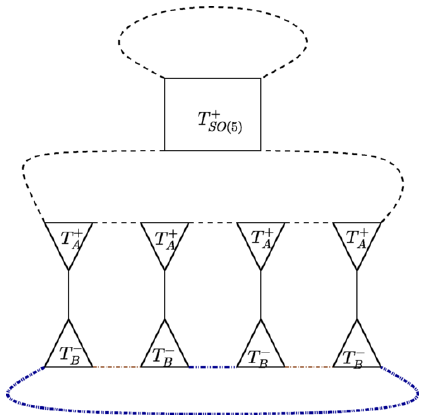
Figure 13 . Construction of genus six theory with minimal value of (cid:13)ux with G max = u (1) su